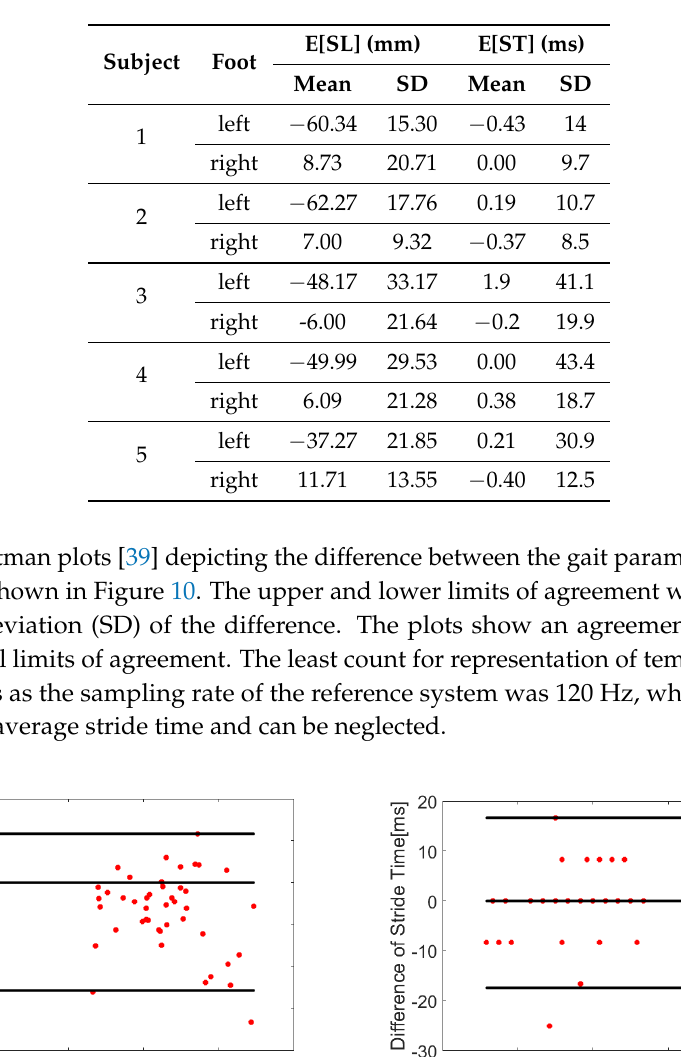
Table 4. Mean and Standard deviation(SD) of error between the gait parameters estimated from proposed and motion capture system at a walking speed of 0.83 m/s. E[SL] and E[ST] represents the error in step length and stride time respectively.